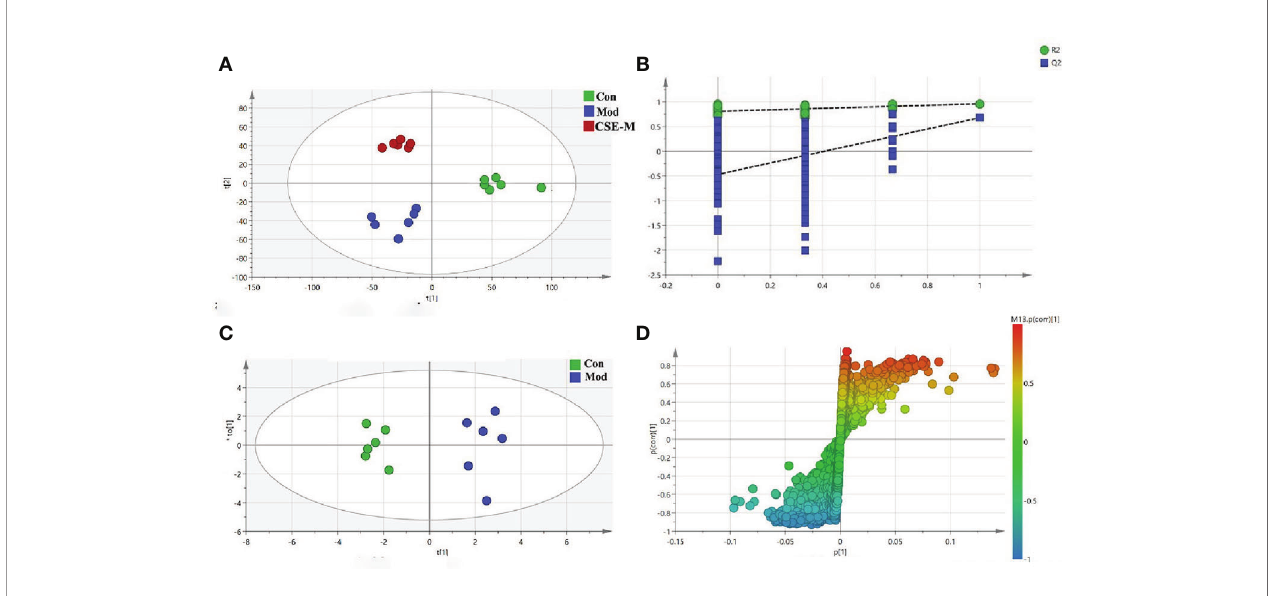
FIGURE 8 | Multivariate analyses of serum 1H-NMR spectra data. (A) PLS-DA plots derived from 1H-NMR spectra on serum of rats in control, model and CSE-M groups. (control group model groups (Con